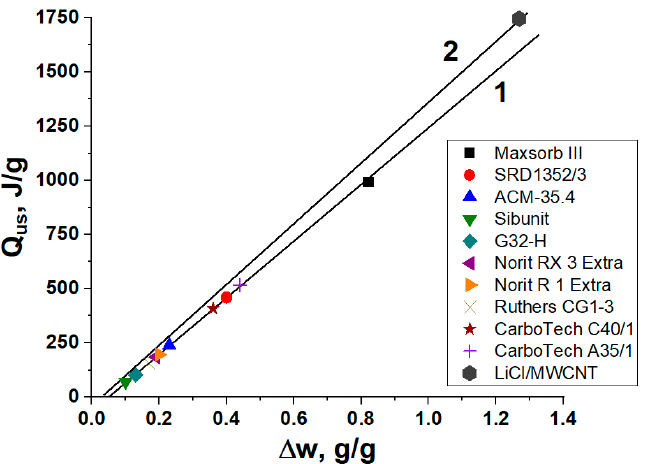
Figure 3. Useful heat of various activated carbons (1) and composite LiCl / MWCNT (2) for cycle 1 (see details in the text).